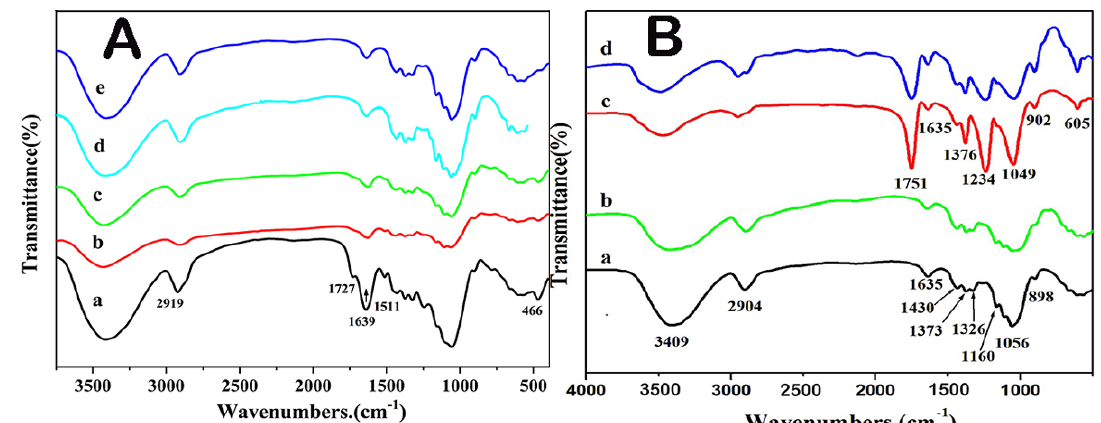
Figure 5. FTIR spectrum ( A ): (a) rice straw powder, (b) pretreated rice straw, (c) pretreated rice straw after secondary washing by C 2 H 5 OH/H 2 O solution, (d) rice straw-derived coarse cellulose, (e) RSC. FTIR spectrum ( B ): (a) RSC, (b) commercial cellulose, (c) RSCA, (d) commercial cellulose acetate.